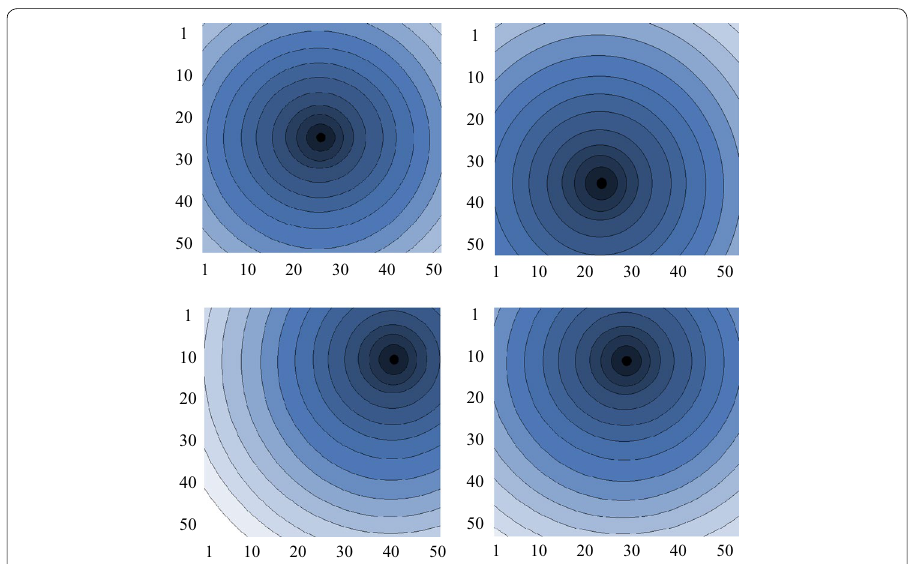
Fig. 12 Four samples of the synthetic images used for 2D-DFT